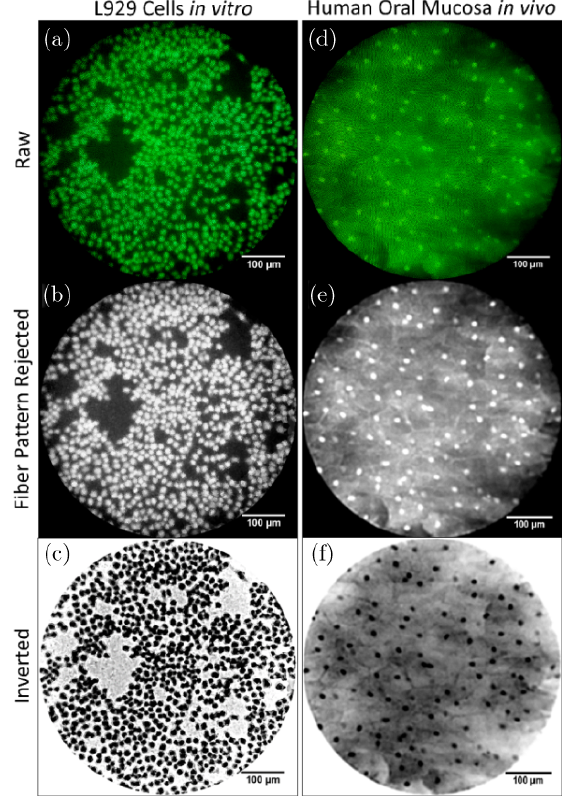
Fig. 4. Raw (a), ¯ber pattern rejected (b) and inverted (c) images of a single layer of L929 cells in vitro . Raw (d), ¯ber pattern rejected (e) and inverted (f) images of normal human oral mucosa in vivo